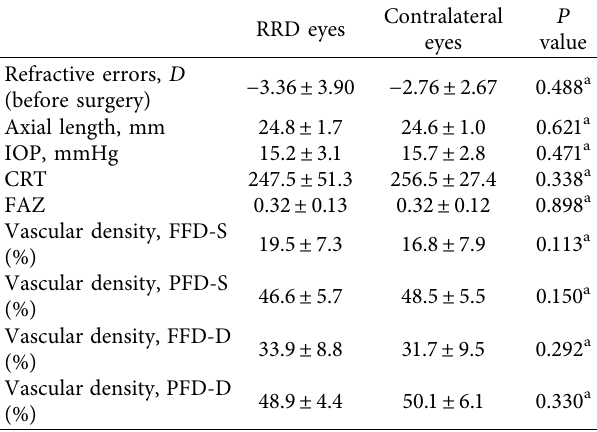
Table 2: Macular characteristics in RRD eyes and fellow eyes using OCT and OCTA three months after PPV surgery.